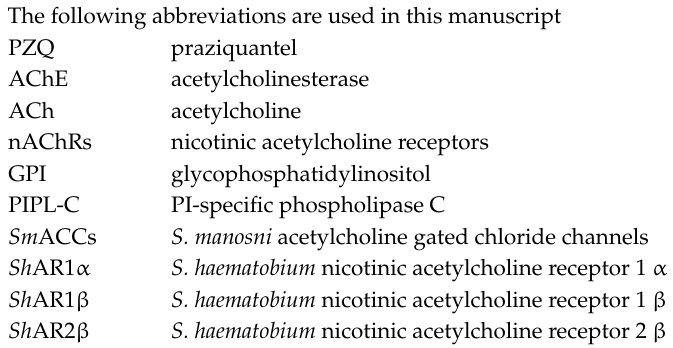
Supplementary Materials: Supplementary materials are available online. Table S1: Amino acid sequences of AChEs and nAChRs identified in S. haematobium , S. mansoni and S. japonicum